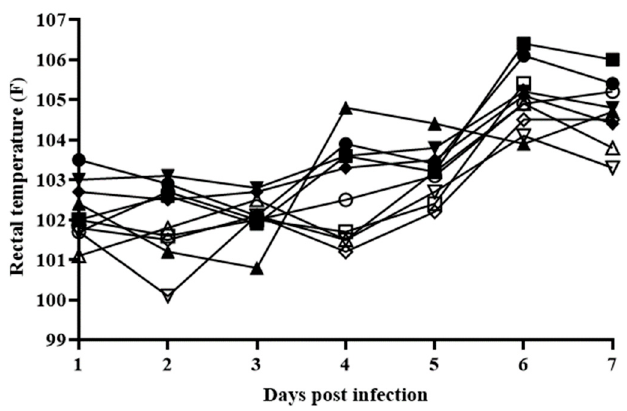
Figure 8. Kinetics of body temperature values in pigs intramuscularly (IM) inoculated with 10 2 HAD 50 of either ASFV-G- ∆ MGF360-16R (filled symbols), or ASFV-G (empty symbols). Each curve represents individual animal values in each of the groups.